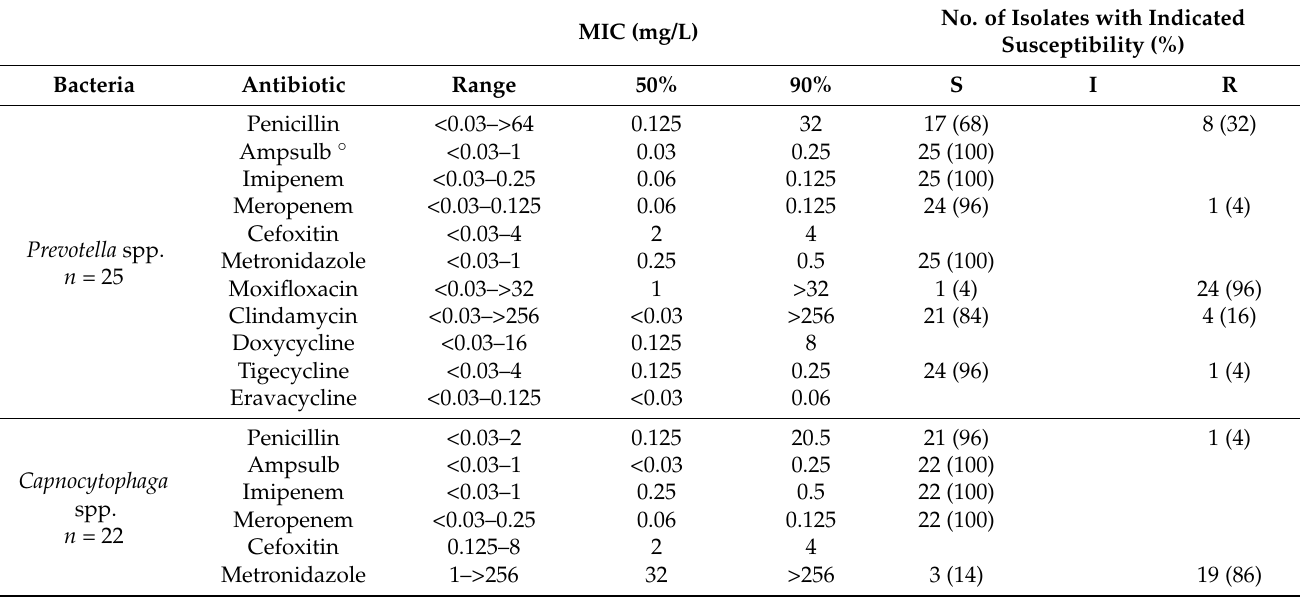
Table 2. Antimicrobial susceptibility of 120 anaerobic bacteria tested with E-test method. No. of Isolates with MIC (mg/L)